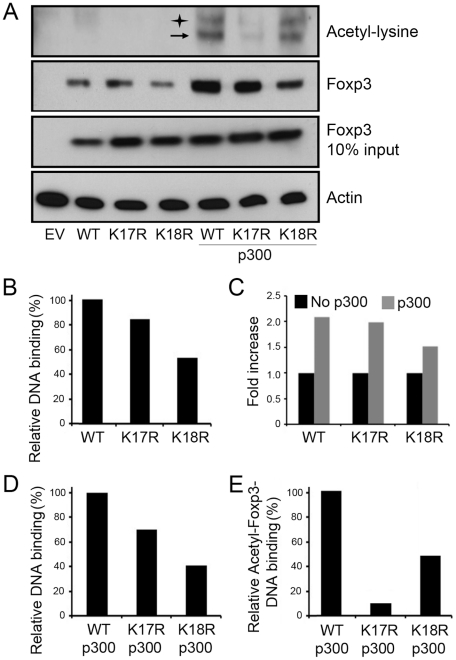
Foxp3 mutants impair Foxp3 DNA binding ability.293T cells were transfected with EV, WT Foxp3, K17R or K18R without or with p300 expression vectors, and 48 h later, cell lysates were harvested. (A) Equal amounts of cell lysates were incubated with biotin-labeled Foxp3 binding site nucleotide, and Foxp3 DNA binding was detected with anti-Foxp3 or anti-acetyl-lysine Abs. The protein expression levels of Foxp3 and loading control β-actin were detected by western blotting; arrow indicates acetylated Foxp3 bound to DNA, and star indicates non-specific binding. (B–D) The densities of Foxp3 DNA-binding bands were measured using Image-J software and normalized with Foxp3 input levels. (B) The relative Foxp3 DNA binding ability in the absence of p300 is shown. (C) Foxp3 and mutant DNA binding ability was increased in the presence of p300. (D) Comparison of relative Foxp3 DNA binding between WT and mutants in the presence of p300 is shown. (E) Comparison of relative acetylated Foxp3 binding level between WT and mutants is shown. Results are representative of 2 independent experiments.